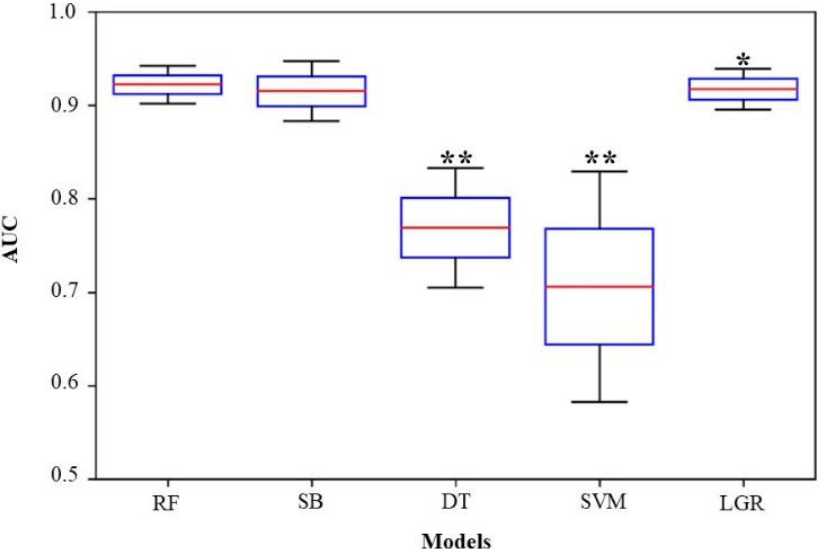
Figure 4. Box-and-whisker plot of the area under the AUC using DeLong’s test. RF showed no statistical difference with AB ( p = 0.359). However, comparisons of RF with DT and SVM showed a significant difference, with p < 0.001 (**). Comparisons between RF and LGR also showed significant difference, with p < 0.05 (*). RF: random forest; AB: adaptive boosting; DT: decision tree; SVM: support vector machine; LGR: logistic regression; AUC: area under the receiver operating characteristic